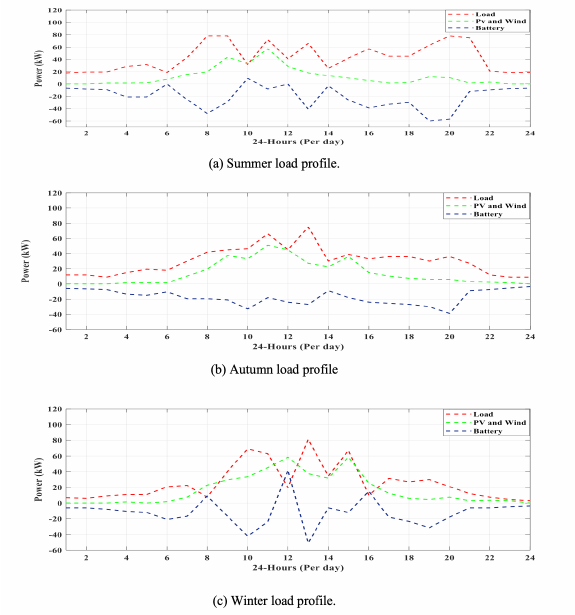
Fig. 8. Load profiles of PV, Wind and Battery energy sources in summer, autumn and